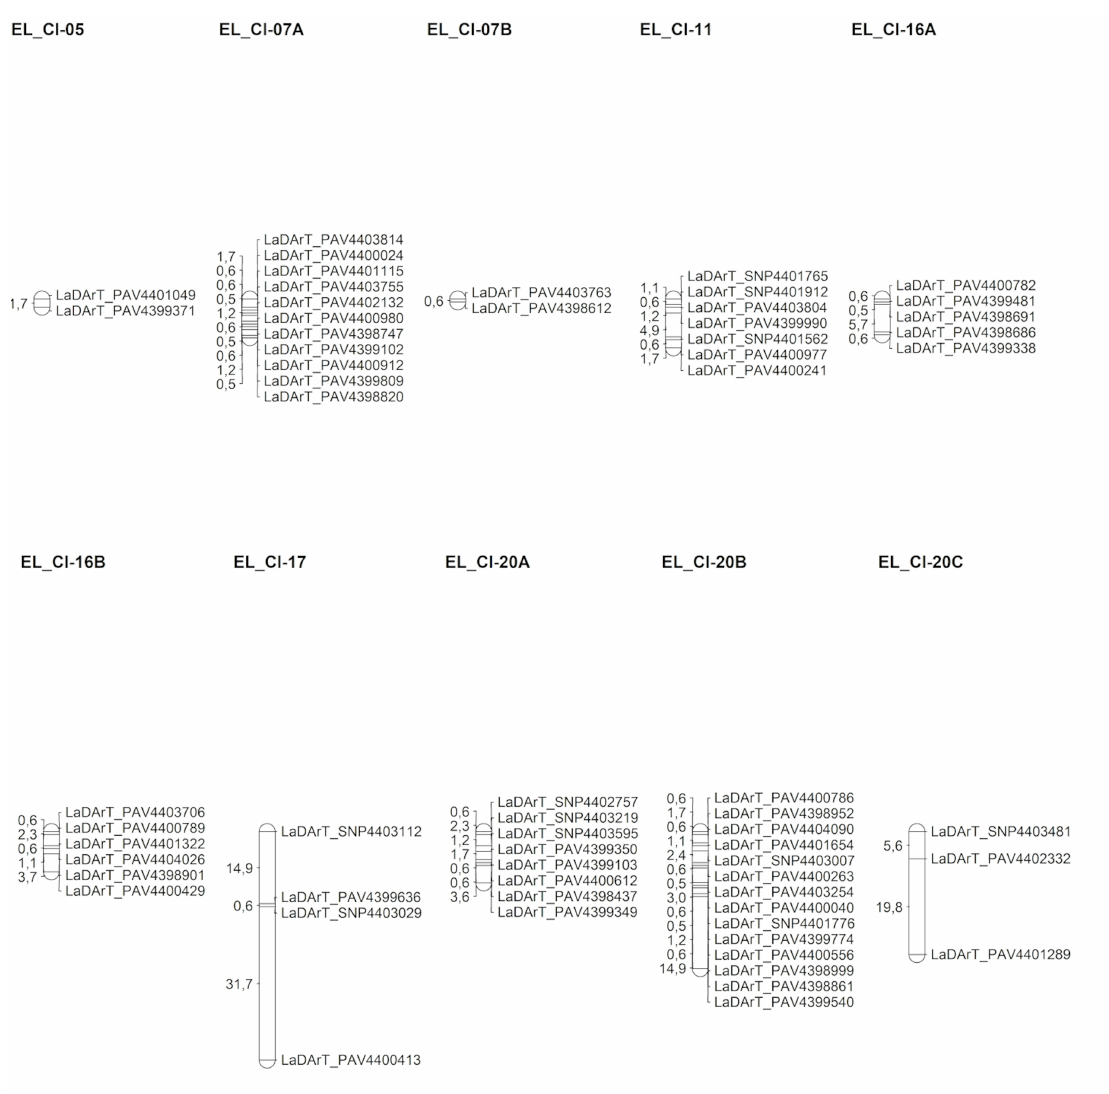
Figure 3. Genetic linkage maps for EL population—Cluster (Cl). Table 4. Pearson correlation coefficient between position of DArTseq markers in genetic linkage maps and narrow-leafed genomes